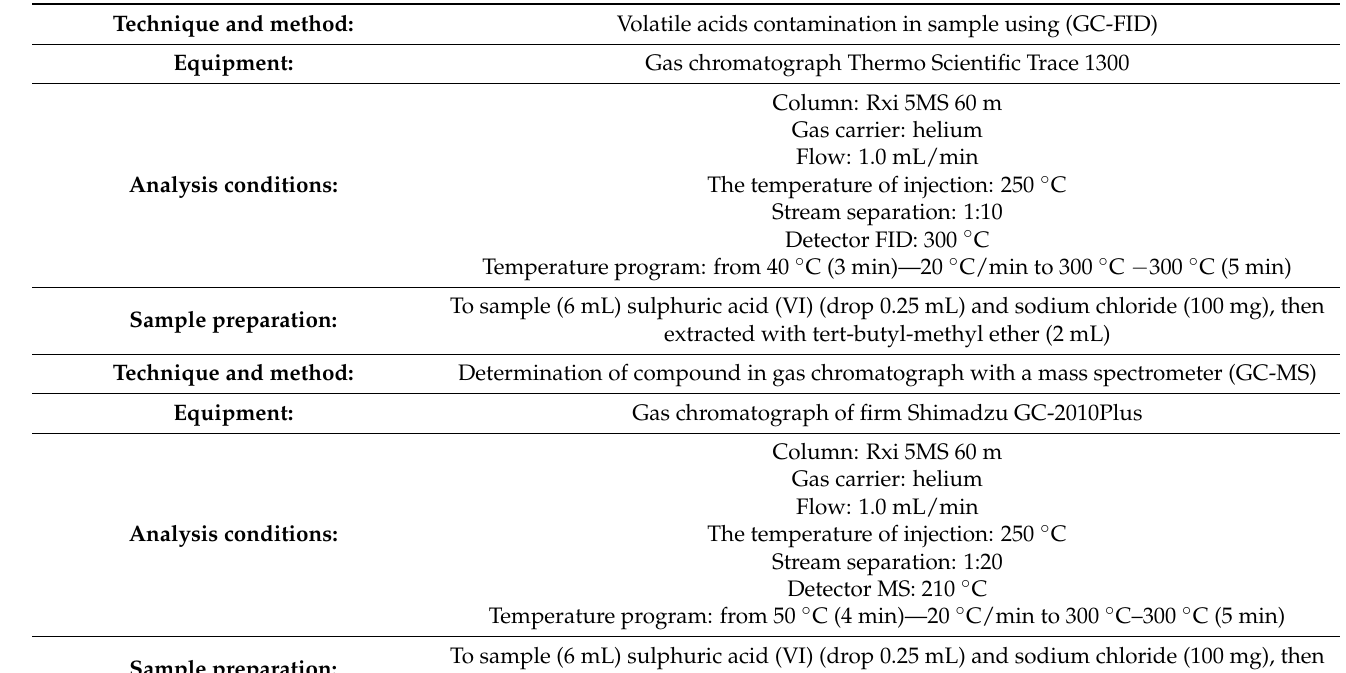
Table 2. Characteristics of volatile acid contamination and determination of